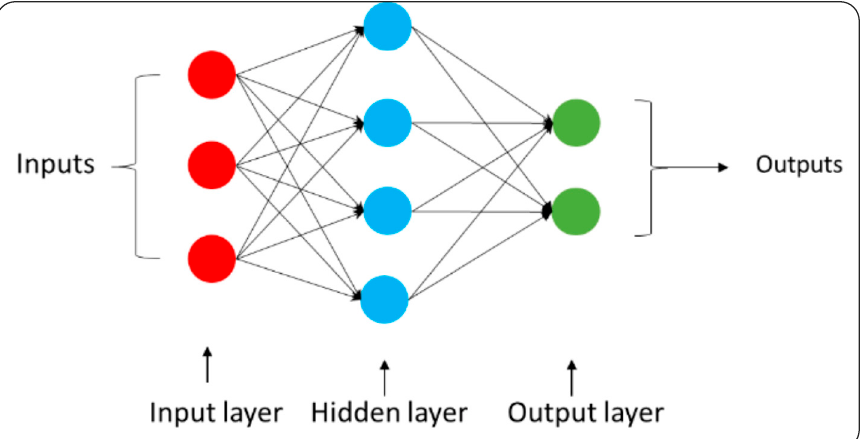
Figure 6. The typical structure of ANN model (adapted from [43]).